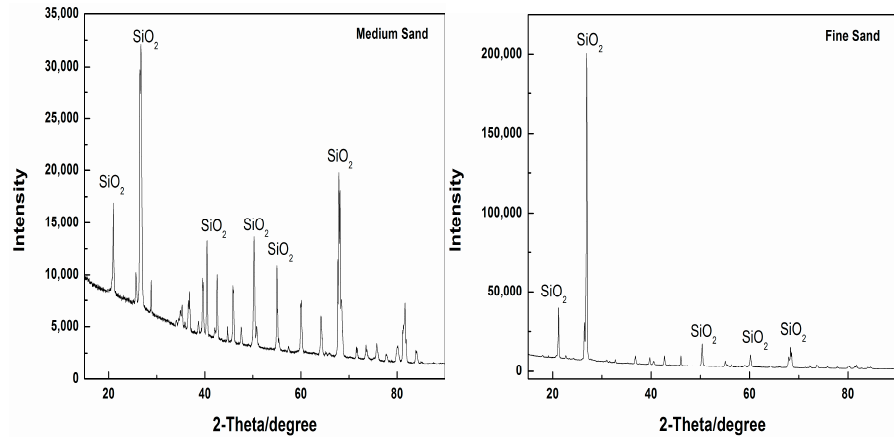
Figure 4. XRD images of the medium and fine sands.